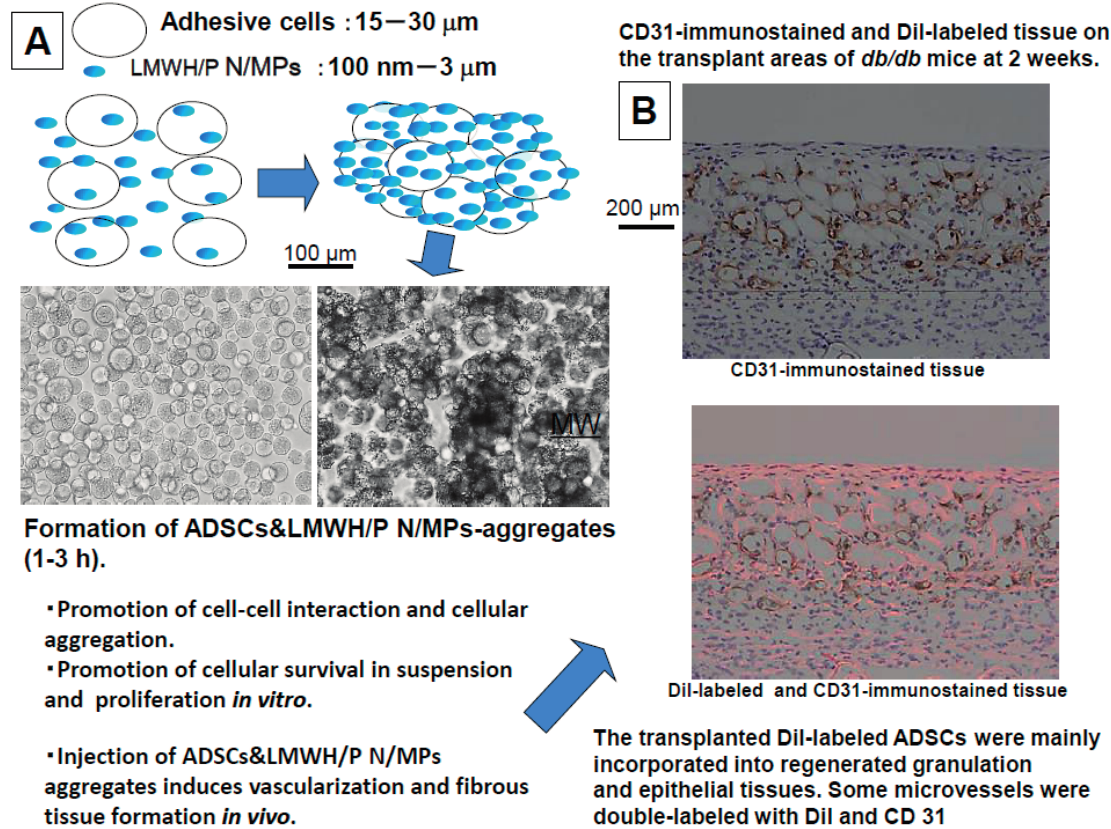
Figure 5. Mechanism of formation of cells and LMWH/P N/MPs-aggregates and in vivo activities. ( A ) Formation of ADSCs&LMWH/P N/MPs; ( B ) Immunostained and Dil-labeled